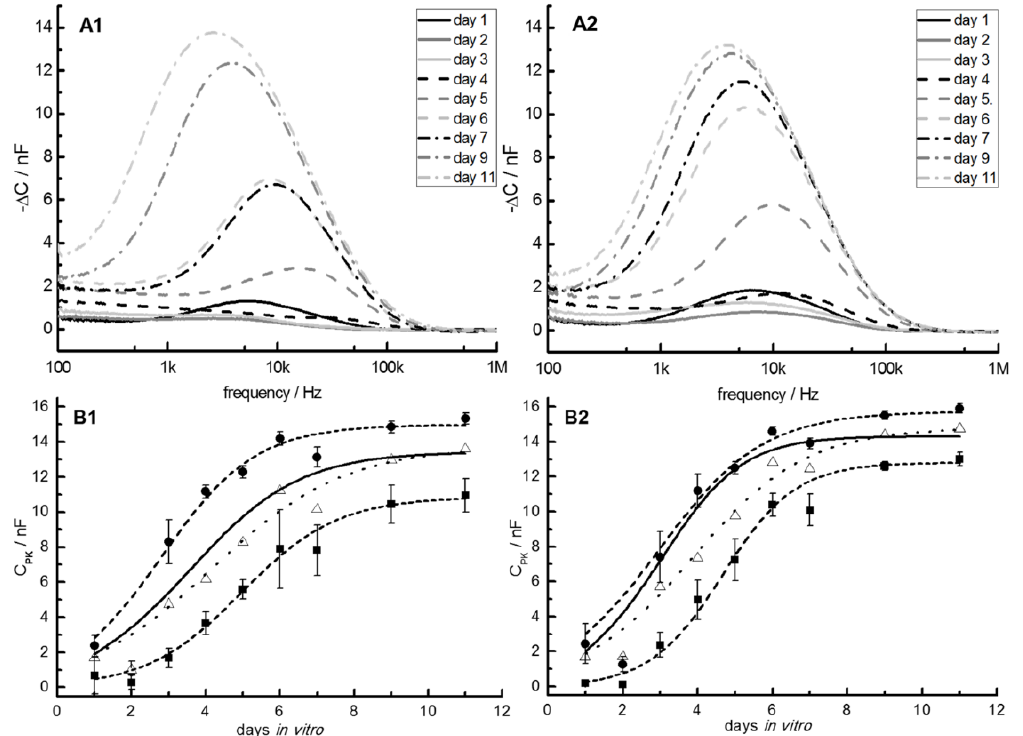
Figure 6. ( A1 , A2 ): Typical examples for the frequency dependencies of the capacitance differences (−∆C) between the IDES capacitance during cell proliferation and the cell-free reference of five chips with four 30-µm IDES ( A1 ) and four 50-µm IDES ( A 2) over 11 days of cell growth. ( B1 , B2 ): For each chip, the C PK values ( i.e. , the –ΔC-peak values, see text) of the spectra were averaged for the four 30-µm ( B1 ) and four 50-µm ( B2 ) IDES. For comparison, curves for the highest (dashed line, circles) and lowest (dashed line, squares) averaged C PK values are shown, reflecting the limits of the cell-proliferation rates observed. From Verhulst-Pearl fits, the parameters in columns A of Table 1 were obtained when the data from all the chips were pooled for a certain IDES pitch (dotted lines). Parameters obtained from averaging the separately fitted parameters of each chip are given in columns B of Table 1 (solid lines). The experimental points for day 2 were not considered in the fits (see